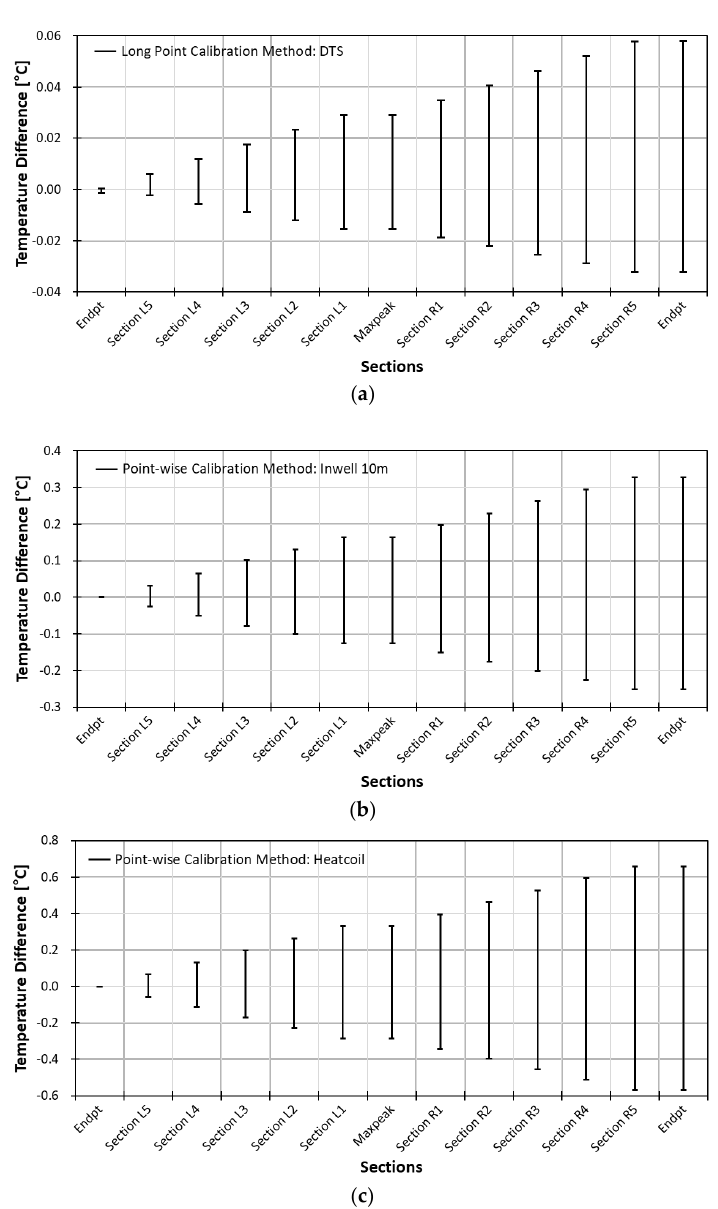
Figure 14. Slope stability of ( a ) long point calibration with water tub ( b ) pointwise calibration with in-well and ( c ) pointwise calibration with heat coil.